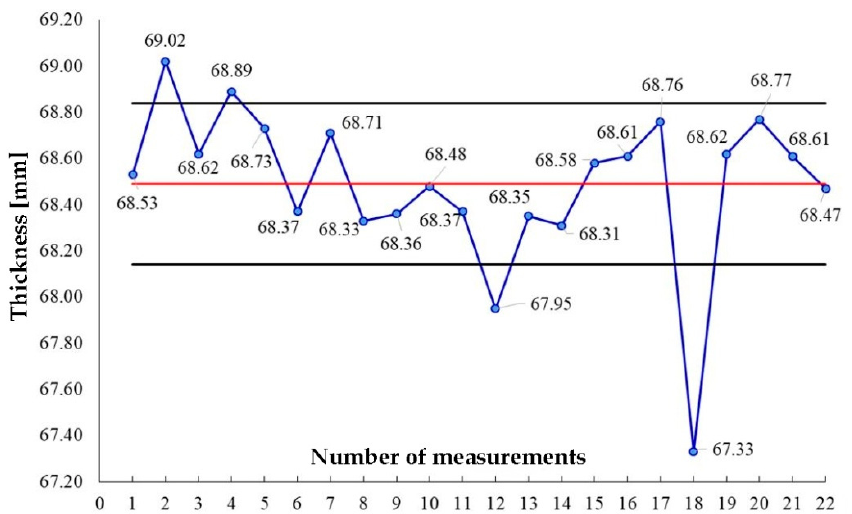
Figure 6. Inner rubber band width variance for CG500.